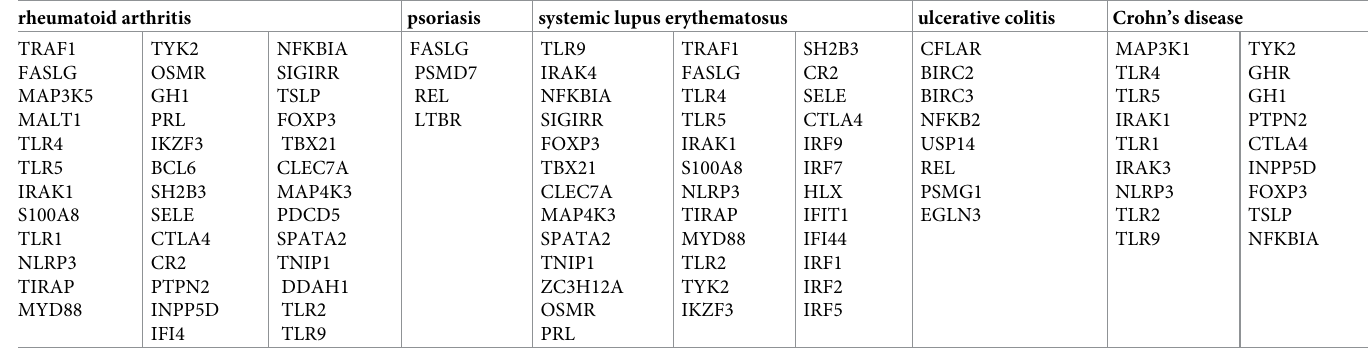
Table 7. Pathogenesis genes in the highly connected modules that were identified by spectrum partition on the subnetworks formed by pathogenesis genes, recep- tors, and cytokines, in the context of five immune disorders: rheumatoid arthritis (RA), psoriasis (PS), ulcerative colitis (UC), Crohn’s disease (CD) and systemic lupus erythematosus (SLE). The table shows that 36 disease genes were identified out of 1,340 disease-associated genes for RA (2.7%), four disease genes from the 542 genes for PS (0.7%), 35 disease genes from the 793 genes for SLE (4.4%), eight disease genes from the 654 genes for UC (1.2%), and 18 disease genes from the 622 genes for CD (3%). Note that many of these disease-associated genes are related to immune